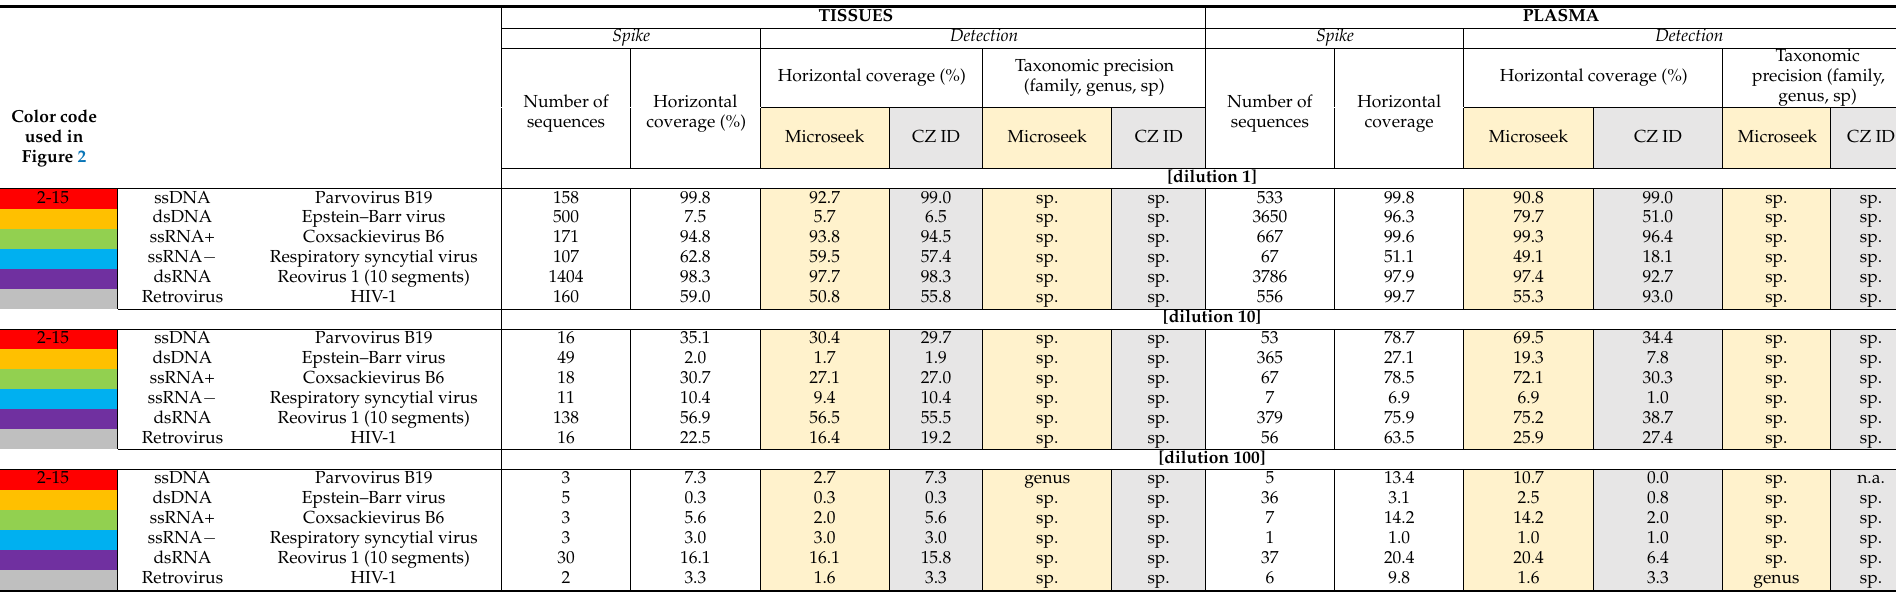
Table 1. Detection of known viruses. The table represents the detection of spike vs. detected sequences of the six known viruses at dilution 1, dilution 10 and dilution 100 in the Tissue and Plasma experiments. sp.: